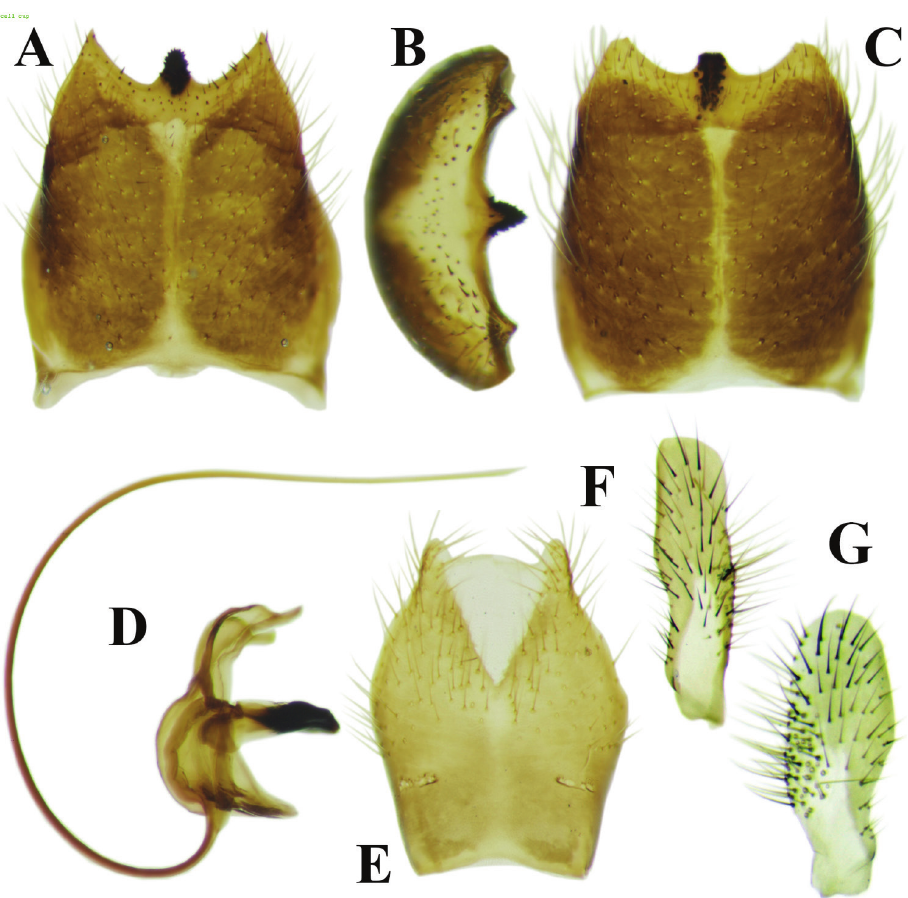
Figure 5. Photographs of the morphological structures of the male genital structures of individuals of Tipula ( Mediotipula ) stigmatella Schummel, 1833. Specimen from Kavala (Greece) A, B, D, E, F Speci- men from Kulata (Bulgaria) G; Specimen from Lunca Bradului (Romania) ( C ) A, C tergite IX dorsal view B tergite IX distal view D aedeagus complex lateral view E sternite VIII ventral view F, G outer gonostylus, lateral